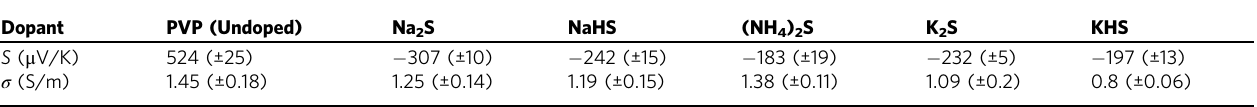
Table 1 Generalizability of doping